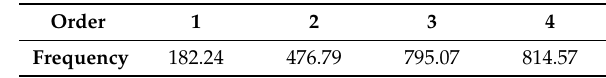
Table 3. The first four natural frequencies after reduction/Hz.